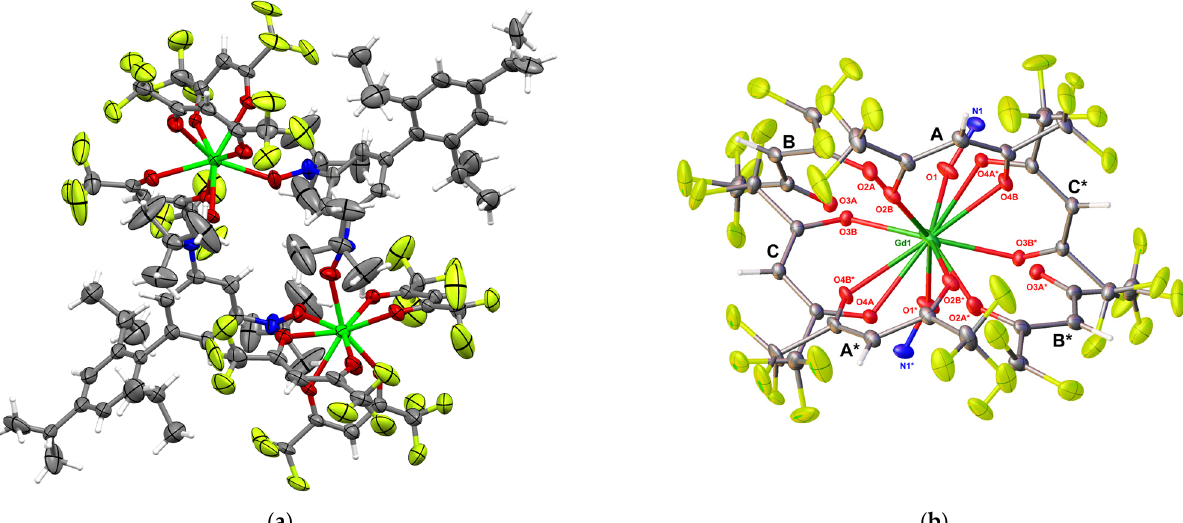
Figure 3. ( a ) X-ray crystal structure of 1 with thermal ellipsoids at the 50% probability level for non-hydrogen atoms. Solvent molecules are omitted. A half of disordered positions is shown. ( b ) An enlarged view of the Gd coordination environment to clarify disordered positions. Selective atomic numbering is also shown. The symmetry relation with (3/4 − y , 3/4 − x , 3/4 − z ) is denoted with *. Color code: C, grey; N, blue; O, red; H, white; F, yellow; Gd, green.